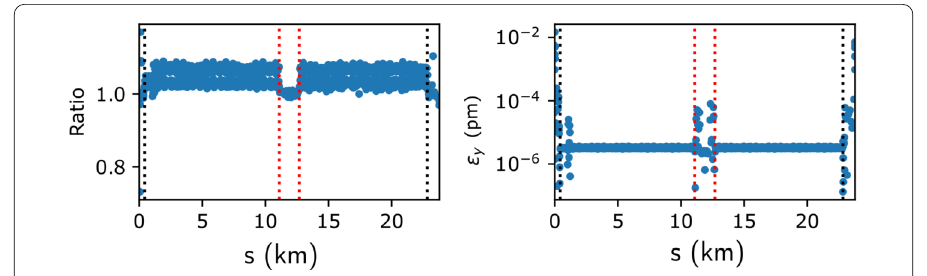
Figure 4 Ratio between vertical emittance from analytical expression and result from MAD-X (left) and absolute value of vertical emittance from analytical expression for 10 μ rad roll errors on single quadrupoles in the FCC-ee. The interface between the arc and IR, and the arc and RF insertion are indicated in black and red respectively